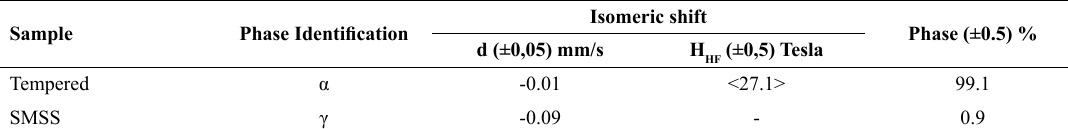
Table 2. Mössbauer Spectroscopy results for tempered sample.